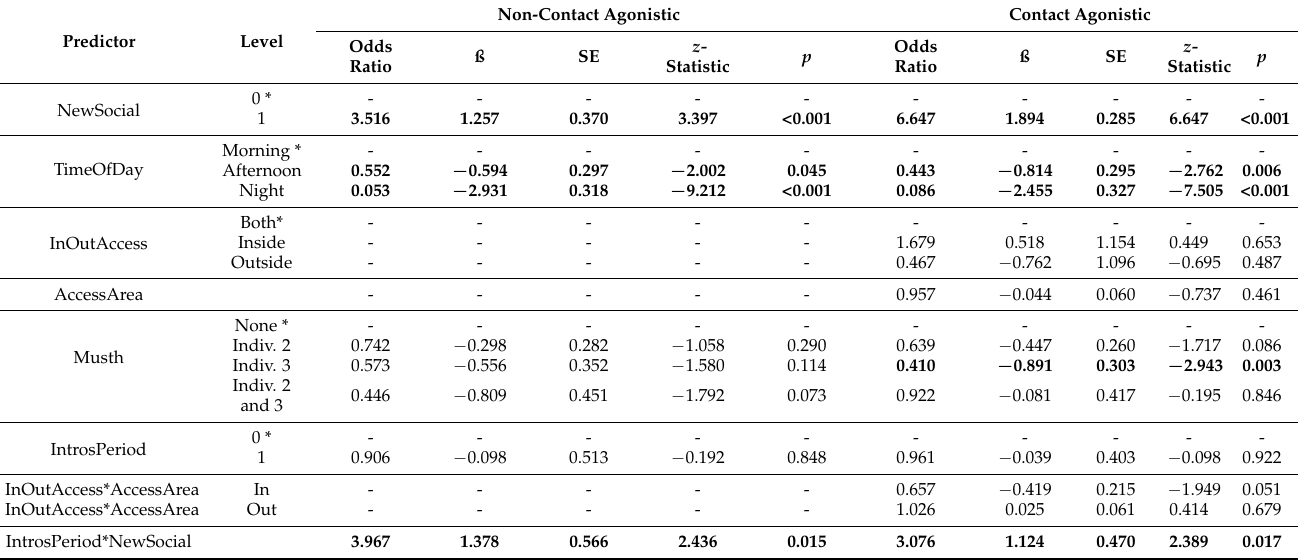
Table A11. New social GLMER model parameter estimates for agonistic response variables. General- ized linear mixed-effect model results of associations between predictor variables (fixed effects) and behavioral response variables for all focal animals. ß = Beta coefficients from model outputs: positive values indicate an increase in odds compared to the reference level while negative values indicate a decrease in odds compared to reference level; SE = standard error of beta coefficients; Wald X 2 = Chi-squared statistic from Wald test with df = 1; p = p -value from Wald test. * indicates